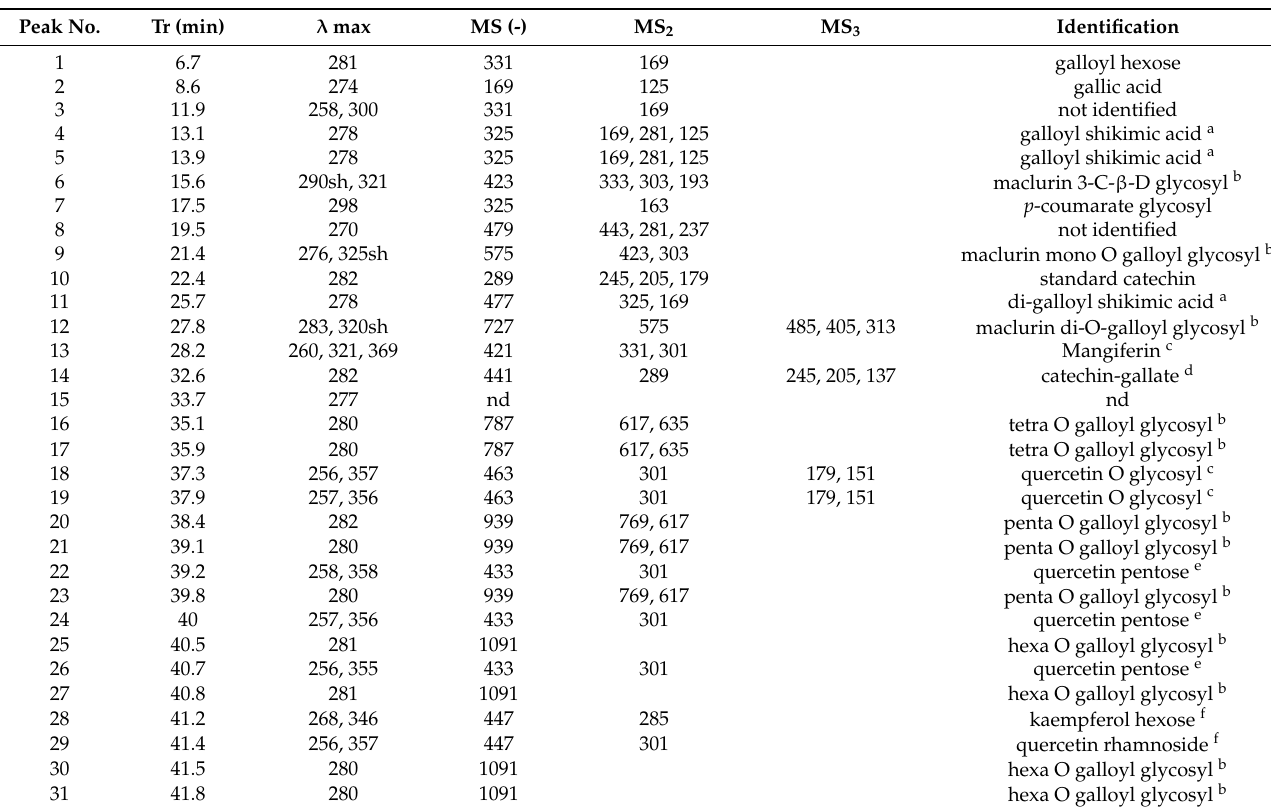
Table 1. Identification of polyphenols in the peel of cv. ‘Cogshall’ mango obtained by HPLC-MSn. nd indicates undetected